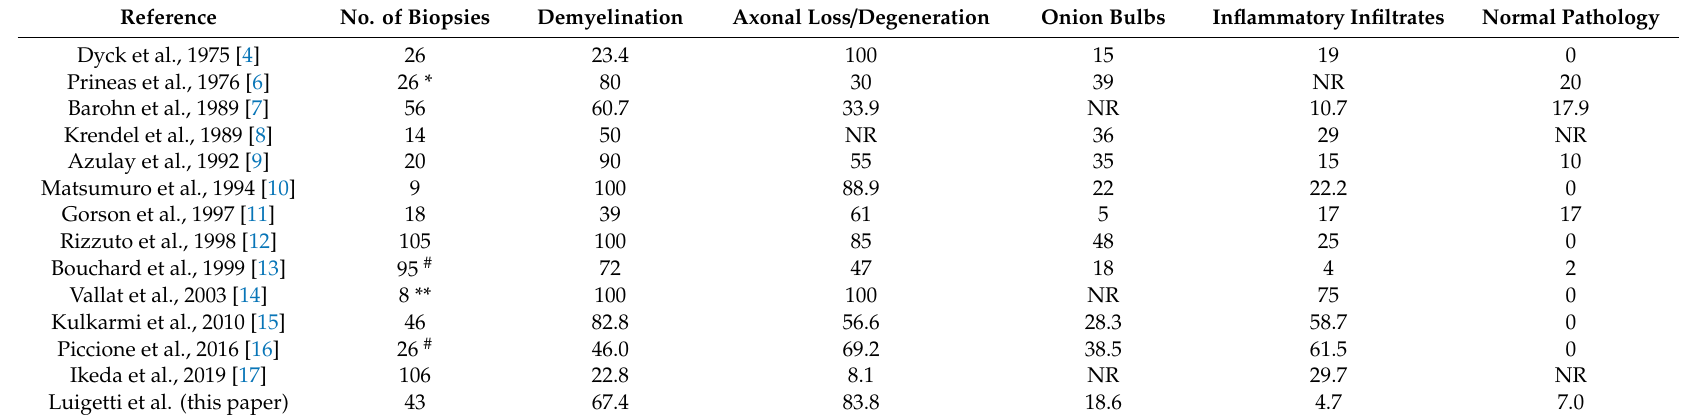
Table 2. Pathological alterations (%) in di ff erent reported cohorts of